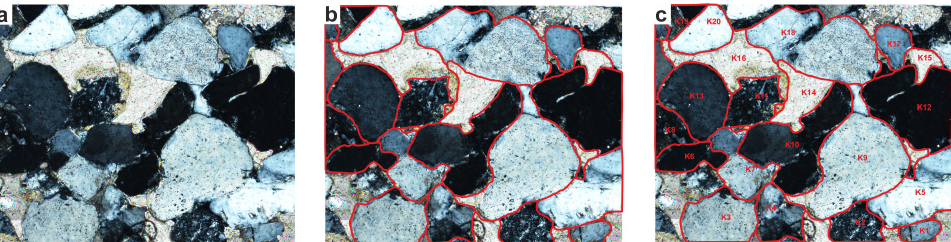
Figure 1. ( a ) Photograph of a part of a thin section of sandstone under an optical microscope, under transmitted light with crossed polarizers, ( b ) thin section with drawn-by-hand borders of individual elements, ( c ) thin section with the numbered components for which the area will be